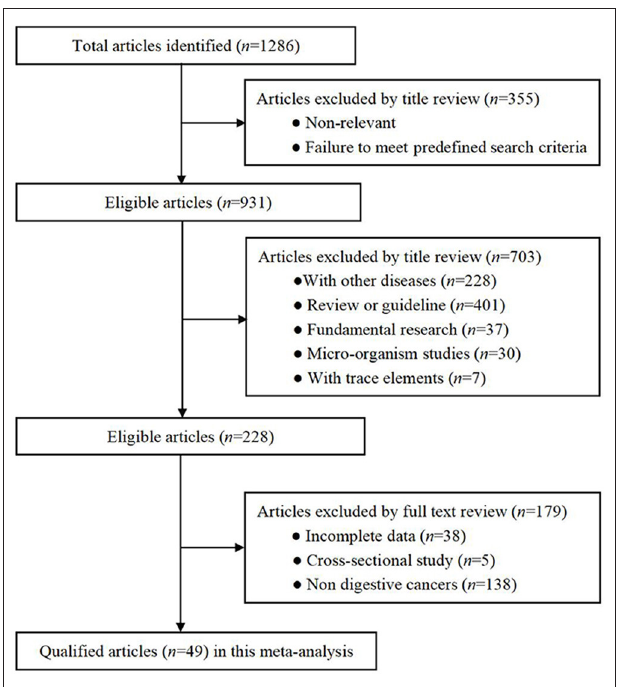
FIGURE 1 | Flow chart of records retrieved, screened and included in this